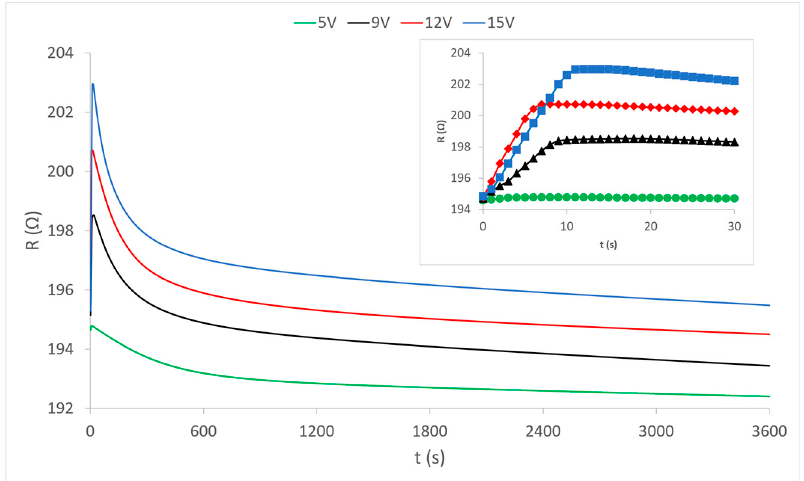
Figure 4. Change in the electrical resistance of the electrically conductive yarn of sample 1 under the influence of temperature change at given voltages.